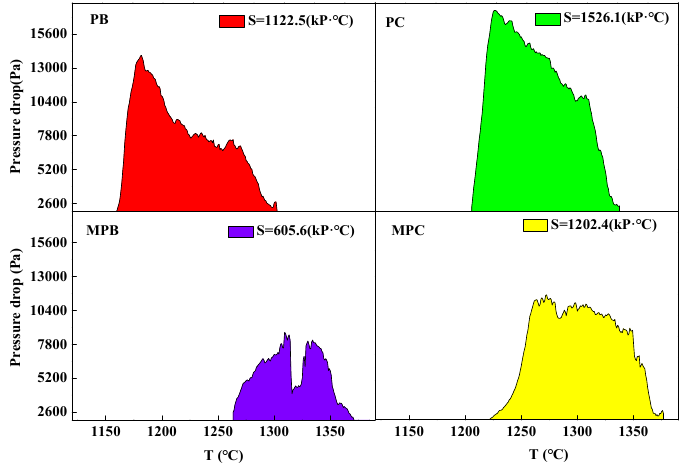
Figure 12. E ff ect of SiO 2 and burden composition on the Figure 12. Effect of SiO 2 and burden composition on the permeability.